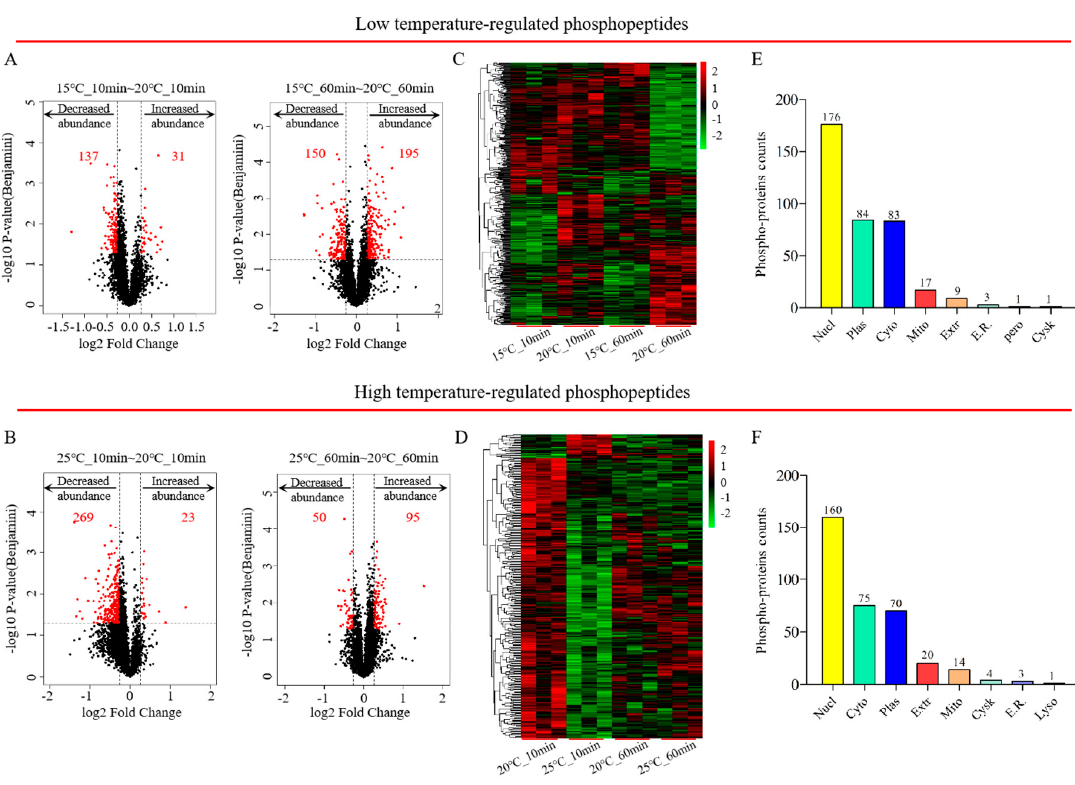
Figure 2. The determination of differentially regulated phosphoproteins (DRPs). Volcano plot analysis of DRPs in C. elegans exposed to 15 °C (A) or 25 °C (B). Heatmap of DRPs in C. elegans at 15 °C (C) or 25 °C (D). Subcellular localization of the phosphoproteins at 15 °C (E) or 25 °C (F).